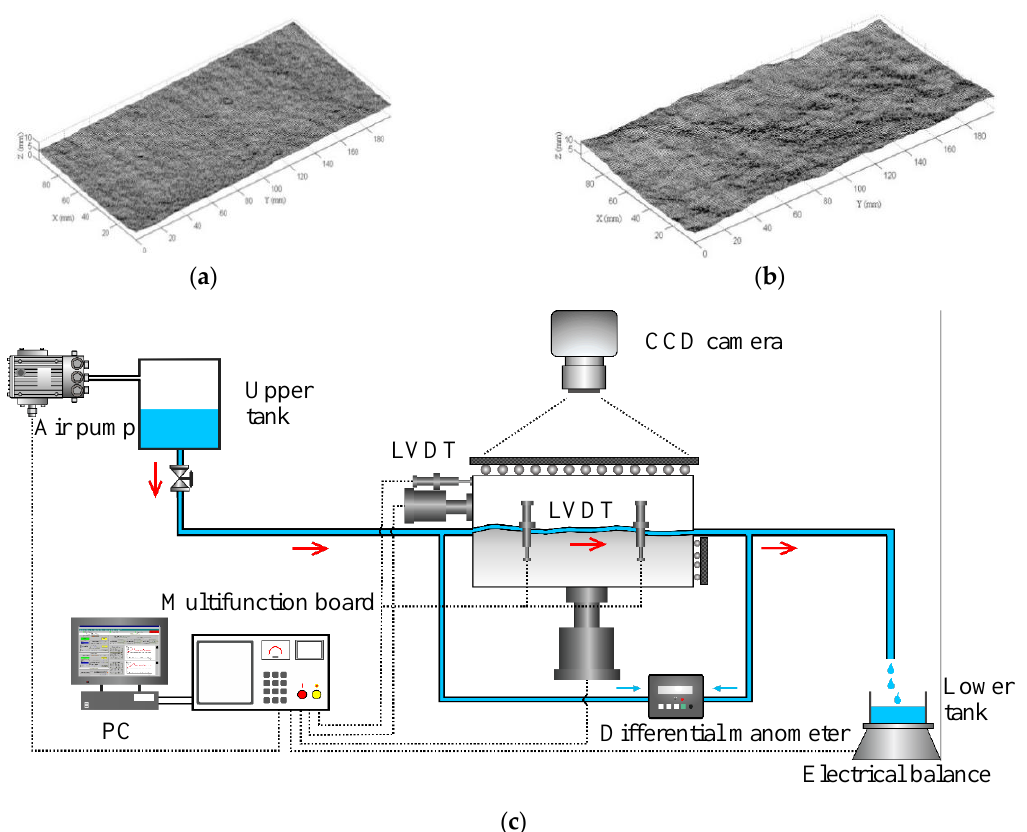
Figure 1. ( a ) Scanning graph of fracture G1. ( b ) Scanning graph of fracture G3. ( c ) Schematic view of the coupled shear-flow test system (Arrow represents water flow direction).